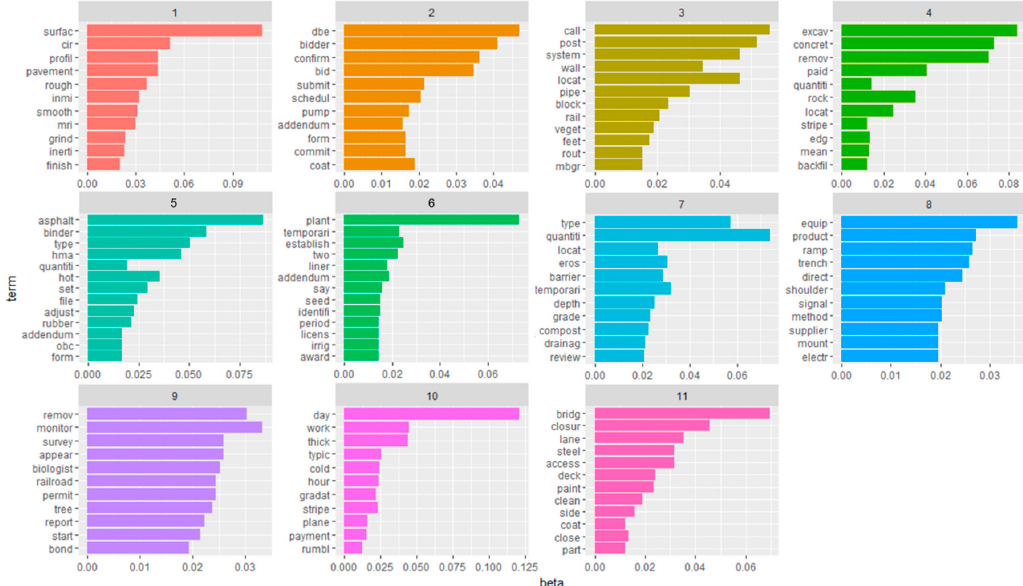
Figure 4. Results of pre-bid Request for Information (RFI) topic modeling.